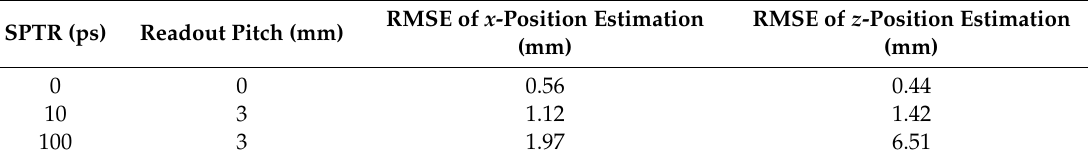
Figure 7. Root mean square error (RMSE) of ( a ) x - and ( b ) z -position estimation, respectively, relative to the SPTR and readout pitch. The results of y -position estimation were omitted because these were very similar to those of x -position estimation. Table 3. RMSE at representative conditions.